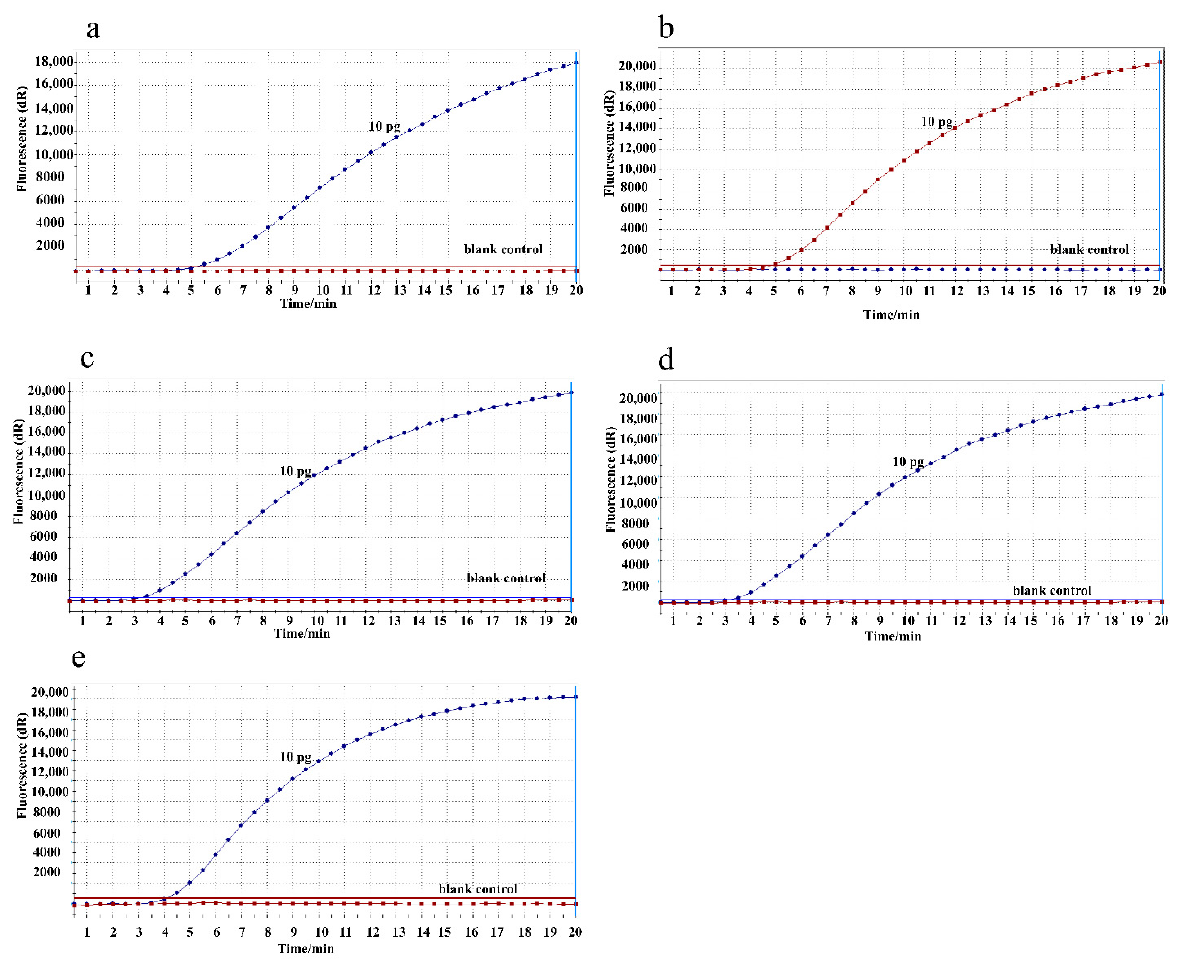
Figure 1. Temperature optimization for the RPA assay. a-e, RPA assay was conducted with 10 pg/ μ L M129 DNA templates in a broad range of amplification temperatures from 37 °C to 41 °C. ( a ) 37 °C; M129 DNA templates in a broad range of amplification temperatures from 37 ◦ C to 41 ◦ C. ( a ) 37 ◦ C; ( b ) 38 °C; ( c ) 39 °C; ( d ) 40 °C; ( e ) 41 °C. ( b ) 38 ◦ C; ( c ) 39 ◦ C; ( d ) 40 ◦ C; ( e ) 41 ◦